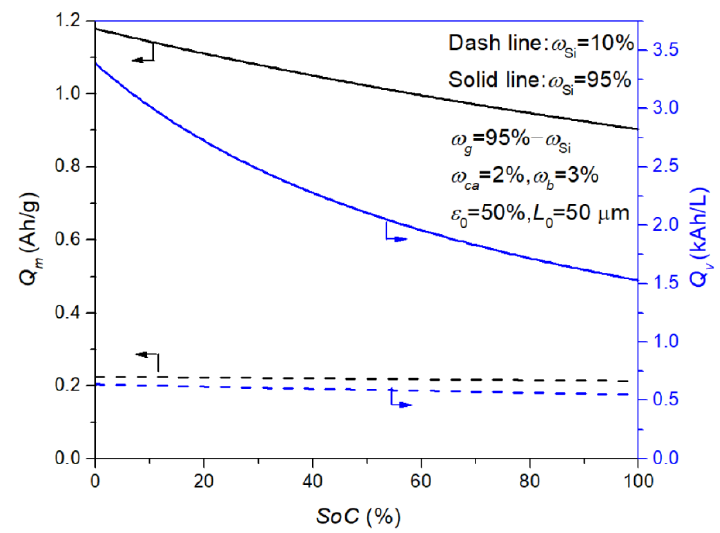
Figure 8. The evolution of gravimetric and volumetric capacity of Si-based electrodes for different mass fractions of Si as a function of SoC during lithiation.